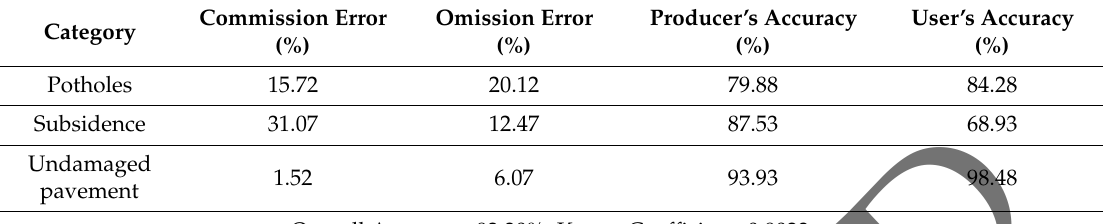
Table 7. Accuracy assessment with the visual interpretation results as a